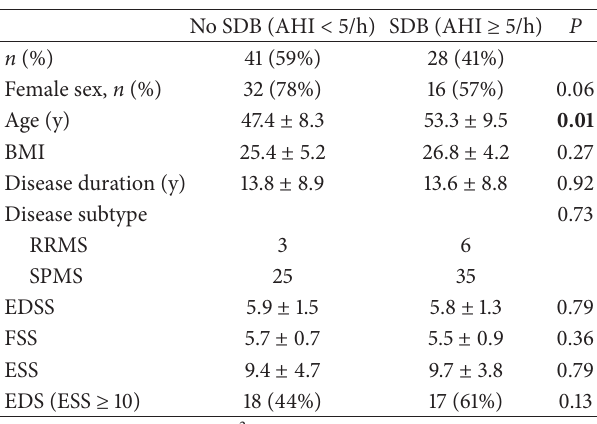
Table 1: Demographic and clinical characteristics in severely fatigued MS patients with and without sleep-disordered breathing.